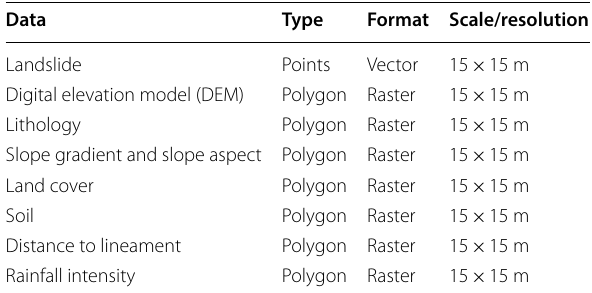
Table 1 Dataset based on GIS system